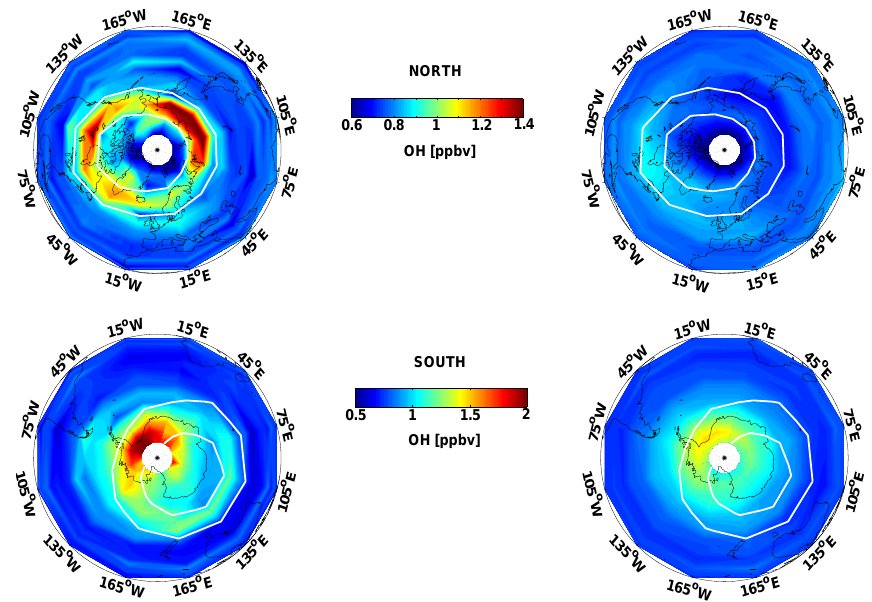
Fig. 4. Top panels: spatial distribution of OH medians in the NH calculated for the days with: (1) ECR > 100 counts/s (left panel) and (2) ECR < 5 counts/s (right panel) for the time period January 2005–December 2009 and altitude range 70–78km. Bottom panels as top panels for the SH. Median values were calculated for each 5 (latitude) × 30 (longitude) degree bin between latitudes 82 ◦ N to 82 ◦ S and longitudes 180 ◦ W to 180 ◦ E. Approximate geomagnetic latitudes 55–72 ◦ N/S are indicated by superimposed white lines.